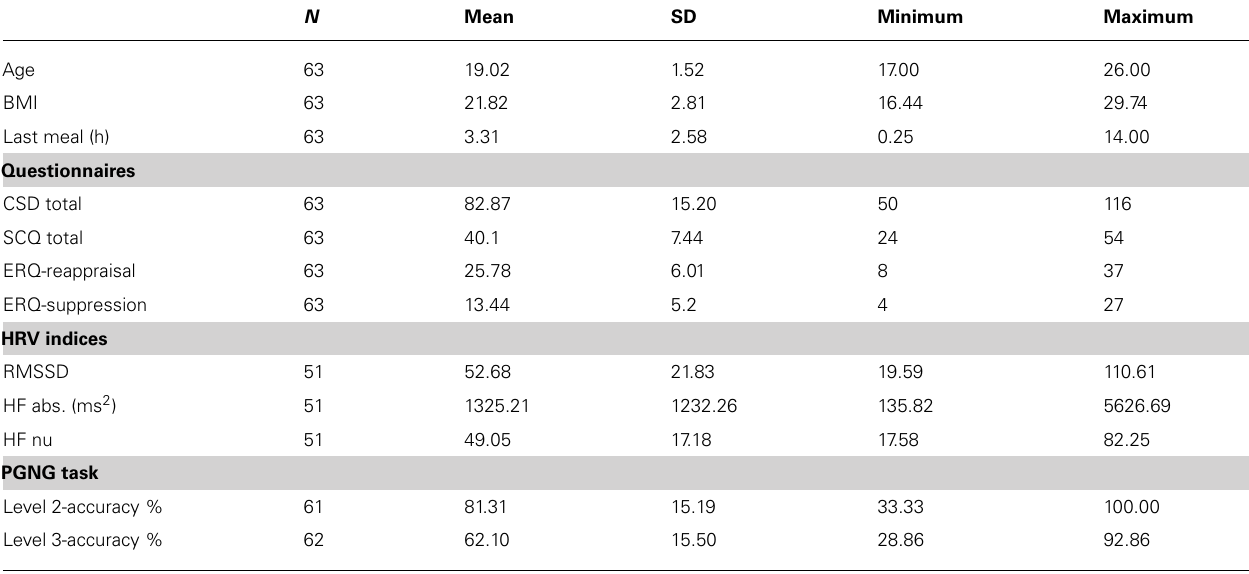
Table 1 | Means and SDs on descriptive variables, questionnaires, PGNG, and HRV indices.